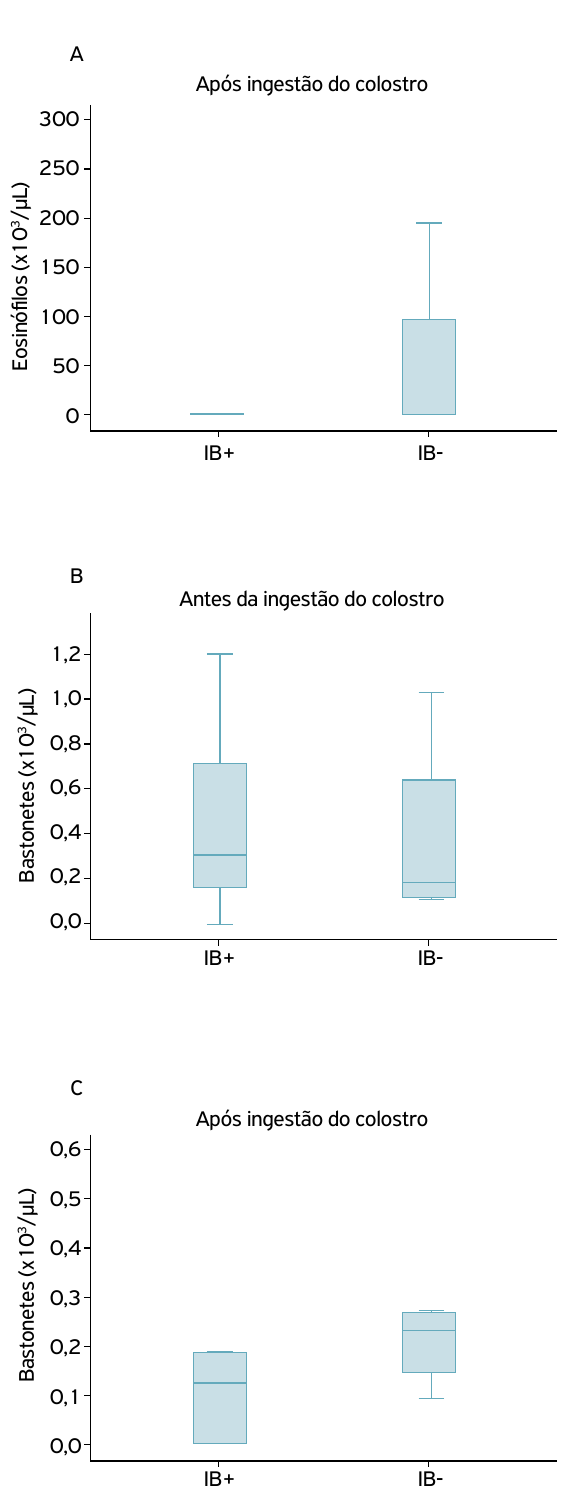
* Outlier . IB+: glândula mamária infectada; IB-: glândula mamária não infectada. Eosinófilos não foram detectados no antes da ingestão de colostro. Figura 1. Valores medianos para os valores absolutos de eosinófilos e neutrófilos bastonetes antes (D0) e depois (D2) da ingestão de colostro oriundo de glândula mamária infectada (IB+) ou não infectada (IB-)